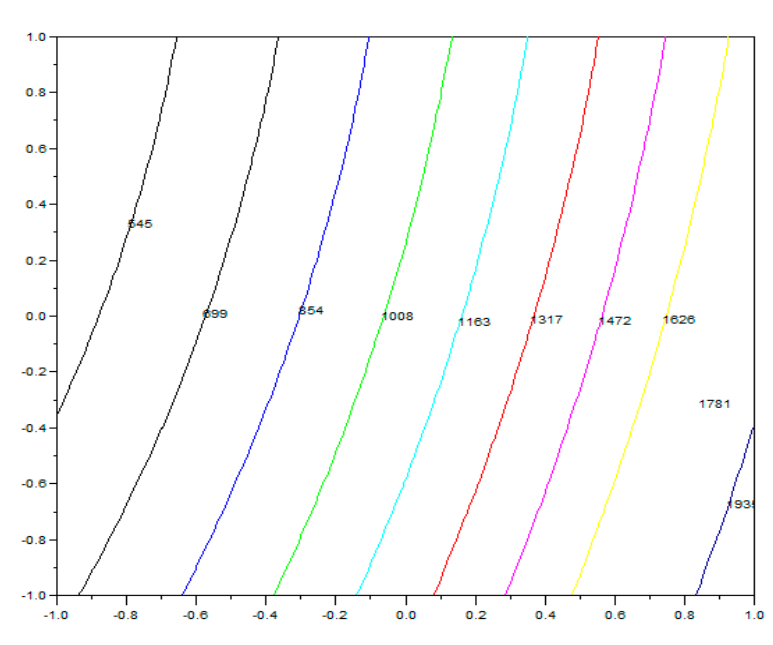
( b ) Contour plot of the cloud model Figure 8. The variance response surface of cloud model. Figure 8. The variance response surface of cloud